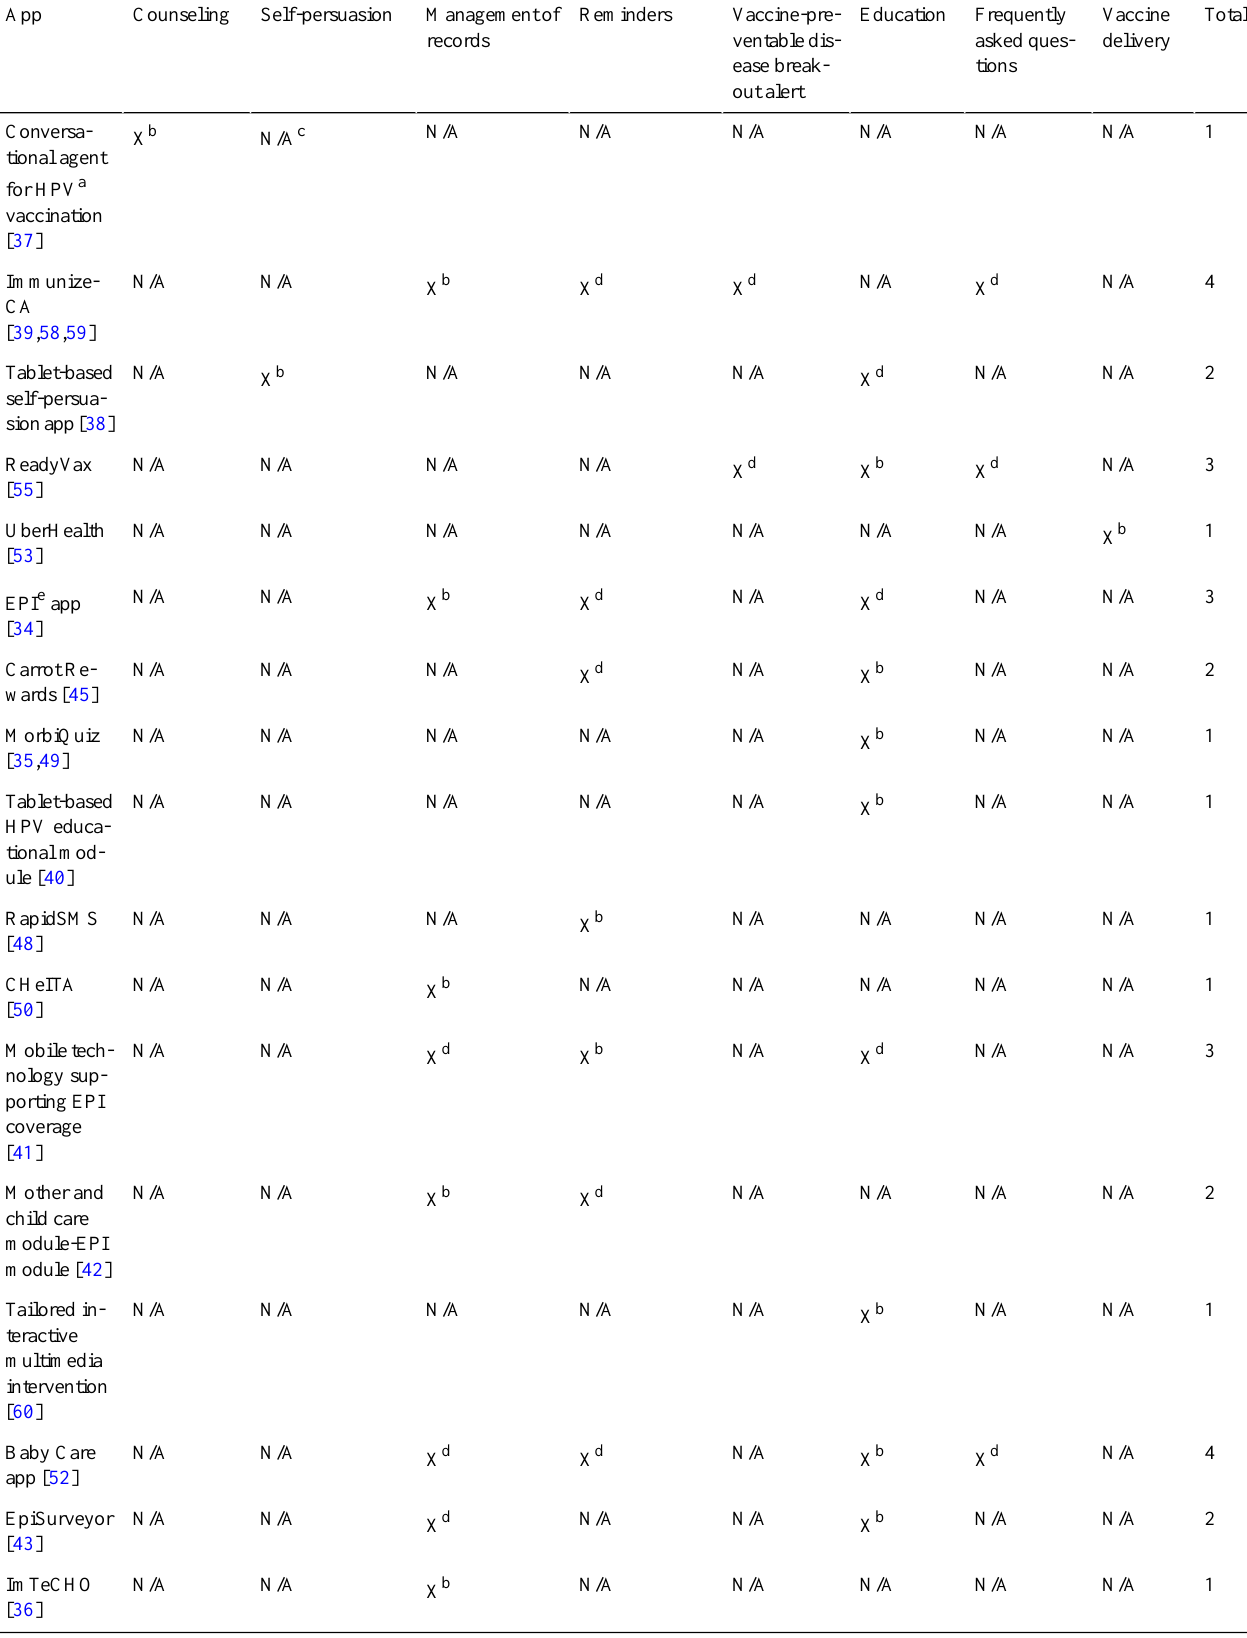
Table 3. Capabilities of the apps described in the included